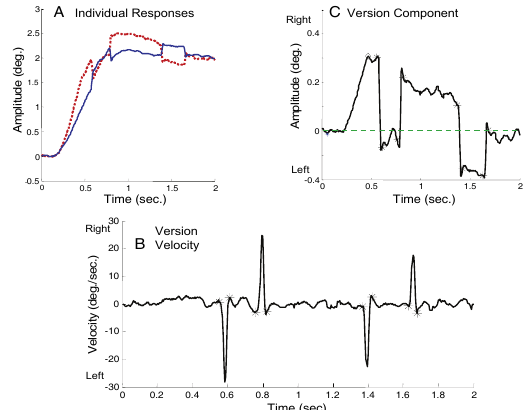
Figure 1 The technique for identifying saccadic time, position, and amplitude information. A) Individual left (dashed red) and right (solid blue) eye movements. B) The velocity trace of the version component showing markers placed to identify the be- ginning and end of each saccade. C) The time plot of the ver- sion component showing the position of the markers obtained from the velocity plot. Saccadic timing information was taken from this plot. The conventions used in this and subsequent figures is to plot convergence as positive for both individual and combined vergence movements as seen in graph A and leftward version movements as negative with the mid-sagittal plane plotted as zero as seen in C.